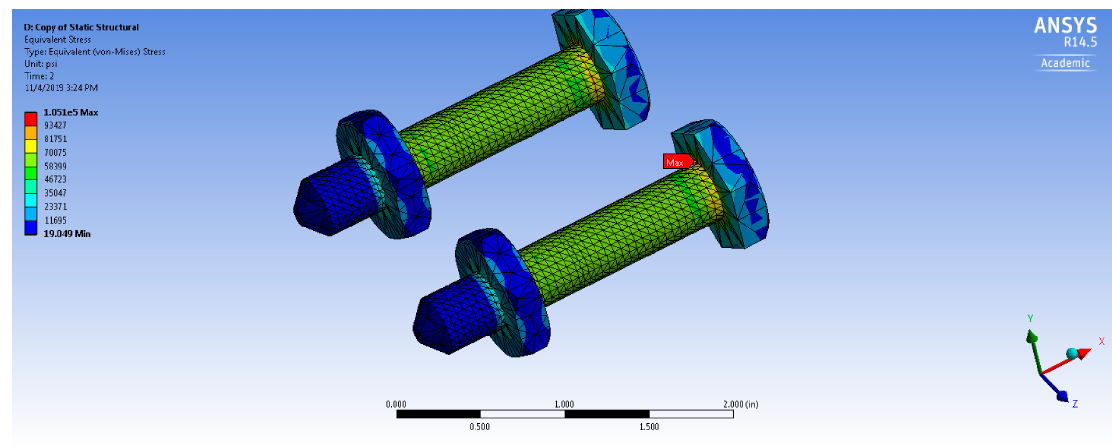
Figure 10. The axial deformation of a preloaded bolted joint.